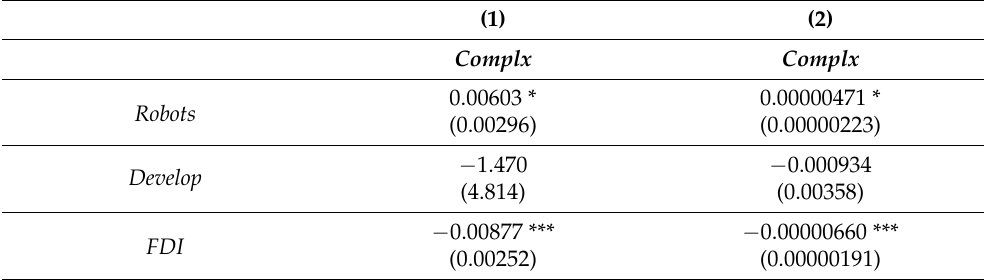
Table 5. Robustness